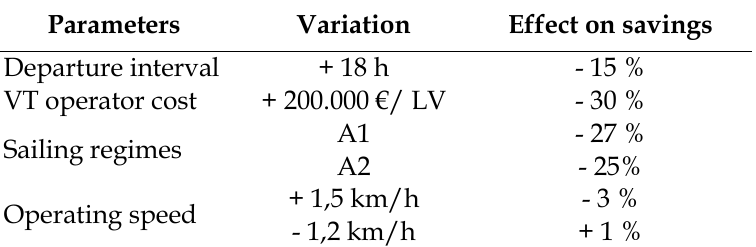
Summary of sensitivity results for different assessment